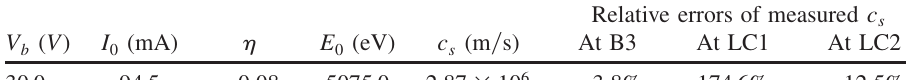
Relative errors of measured c s